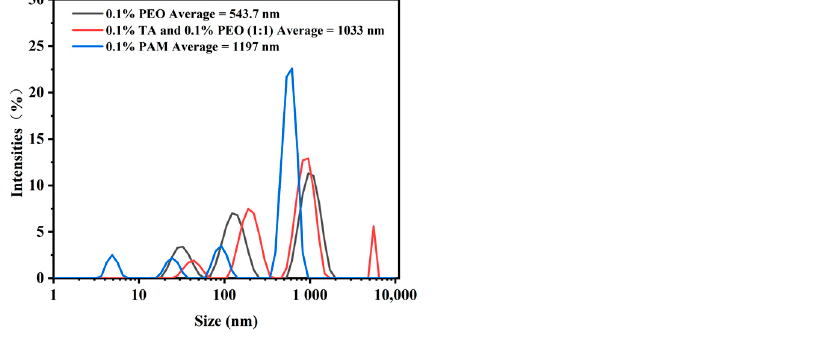
Figure 13. Dynamic Light Scattering measurement: PEO, TA-PEO, and PAM. The bridging and sweeping between quartz particles can be further promoted